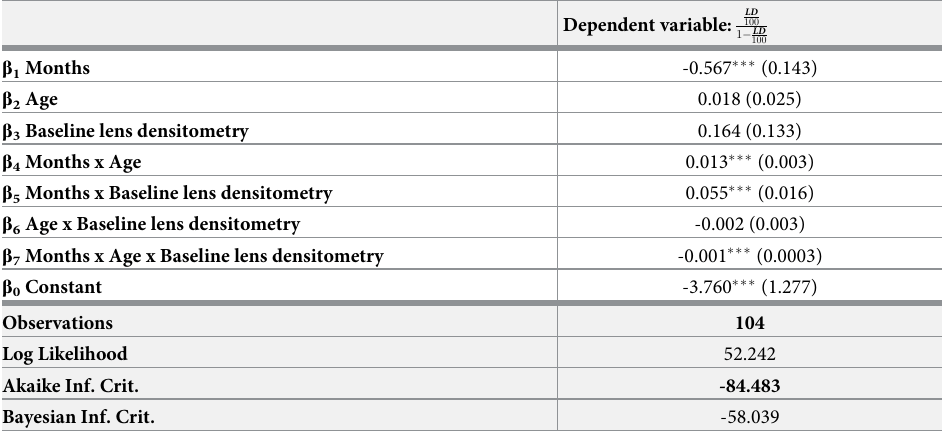
Table 2. Mixed effects regression model parameters β 0 through β 7